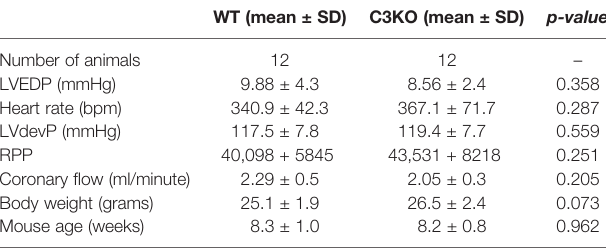
TABLE 1 | Baseline performance at end of 20 minutes stabilization.